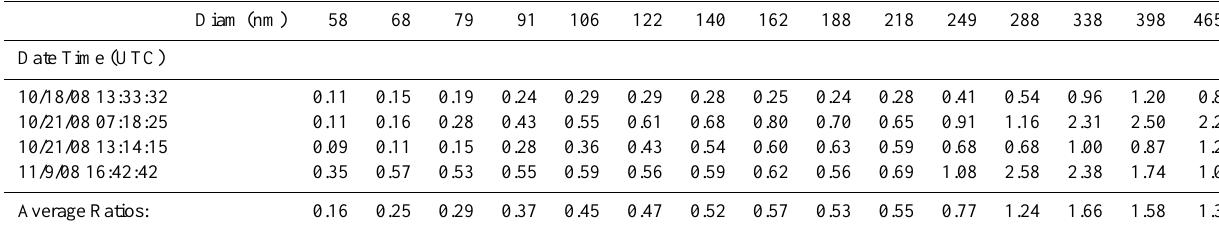
Table 3. Ratio of in-cloud to below-cloud particle concentration for four size distributions shown in Fig. 10.